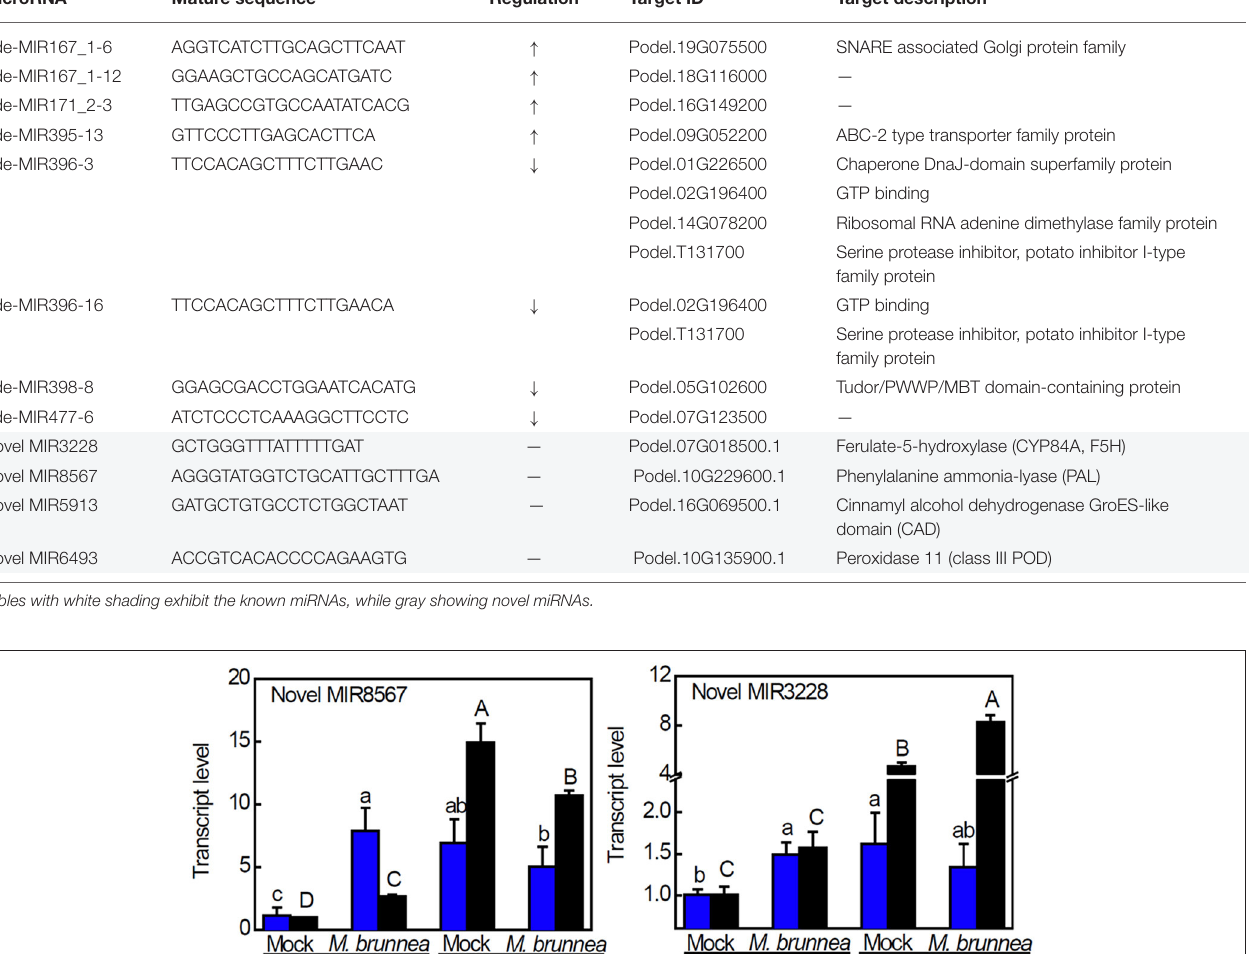
TABLE 2 | Potential known miRNAs, novel miRNAs, and the predicted targets may be involved in poplar response to M. brunnea . MicroRNA Mature sequence